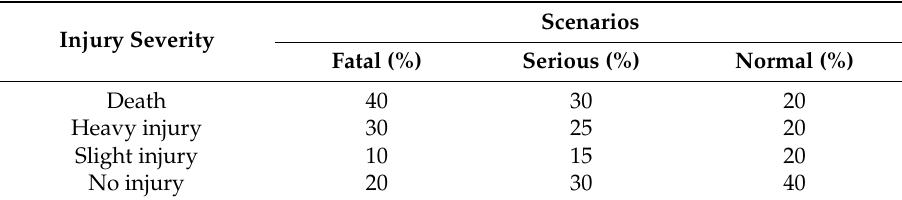
Table 2. The proportions of four injury severities in each scenario.